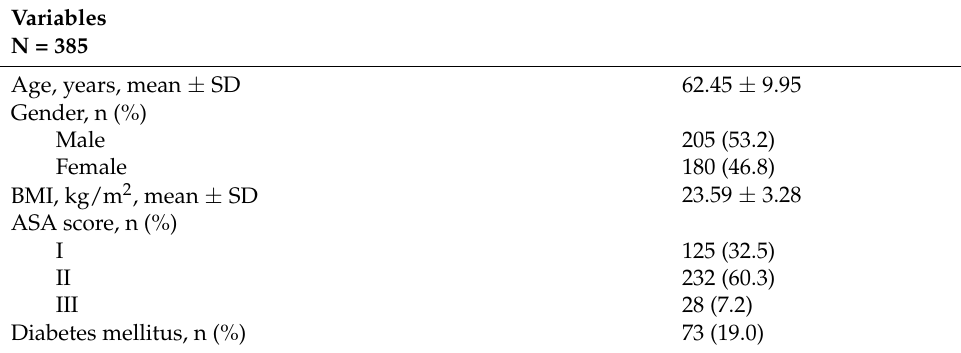
Table 1. Overall patient demographics and postoperative/pathologic